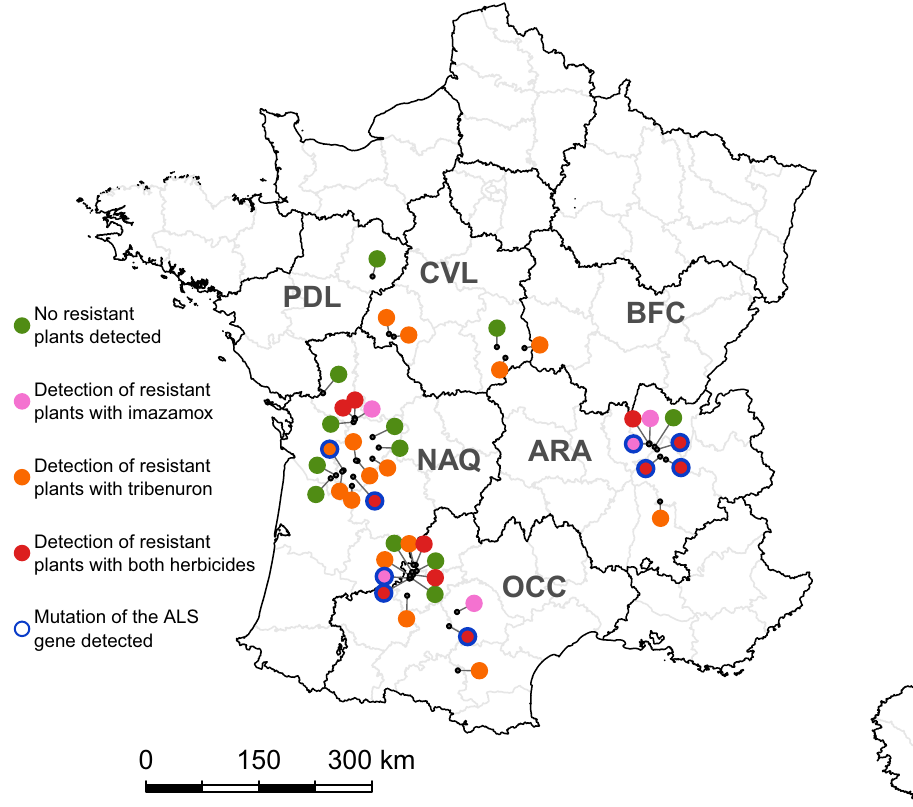
Figure 3. Occurrence of resistance to imazamox, tribenuron and both herbicides in the targeted sampling of 43 common ragweed populations. The presence or absence of resistant plants is indicated by coloured dots. The small grey dot connected to each coloured dot indicates the precise location of the corresponding population. French Région names are coded as follows: ARA, Auvergne Rhône-Alpes; BFC, Bourgogne Franche-Comté; CVL, Centre Val-de-Loire; NAQ, Nouvelle Aquitaine; OCC, Occitanie; PDL, Pays de la Loire. Map generated using R software (v4.1.0, packages rgdal, rgeos and